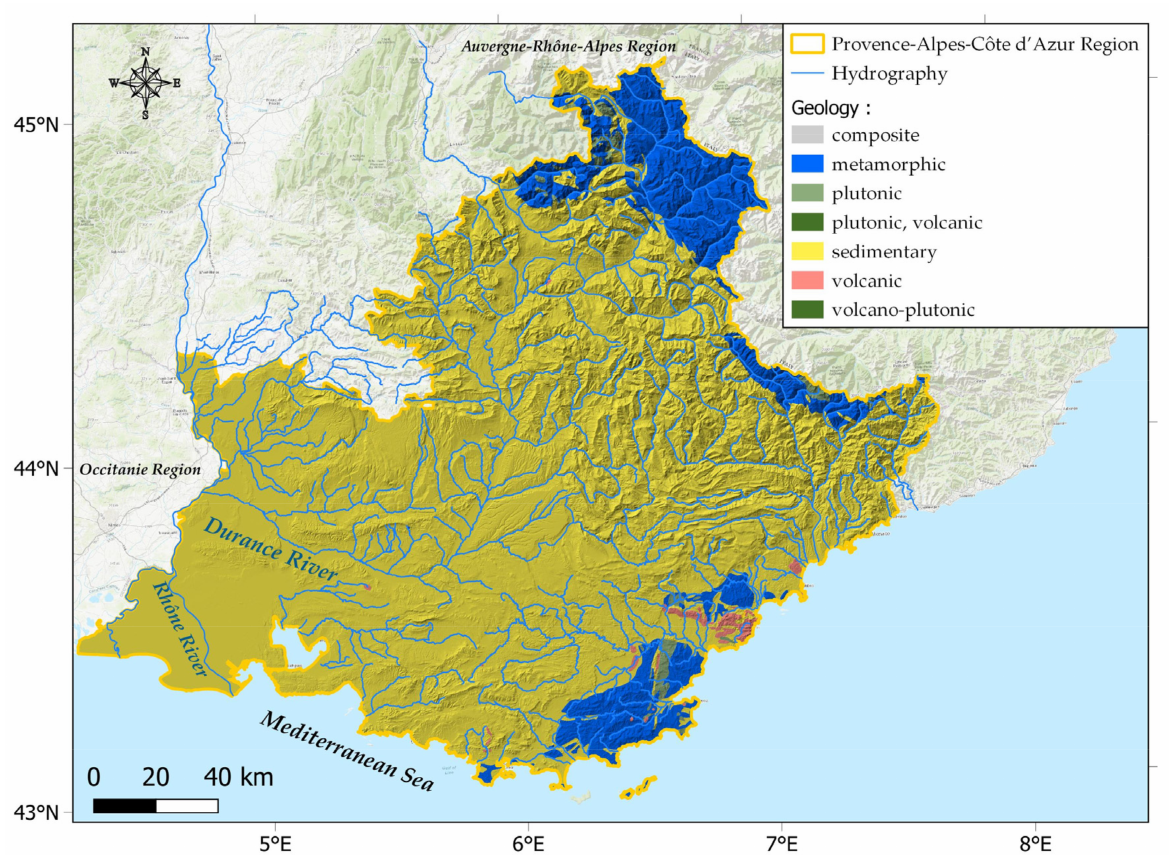
Figure 2. Special distribution of the geological features and hydrographic elements within PACA